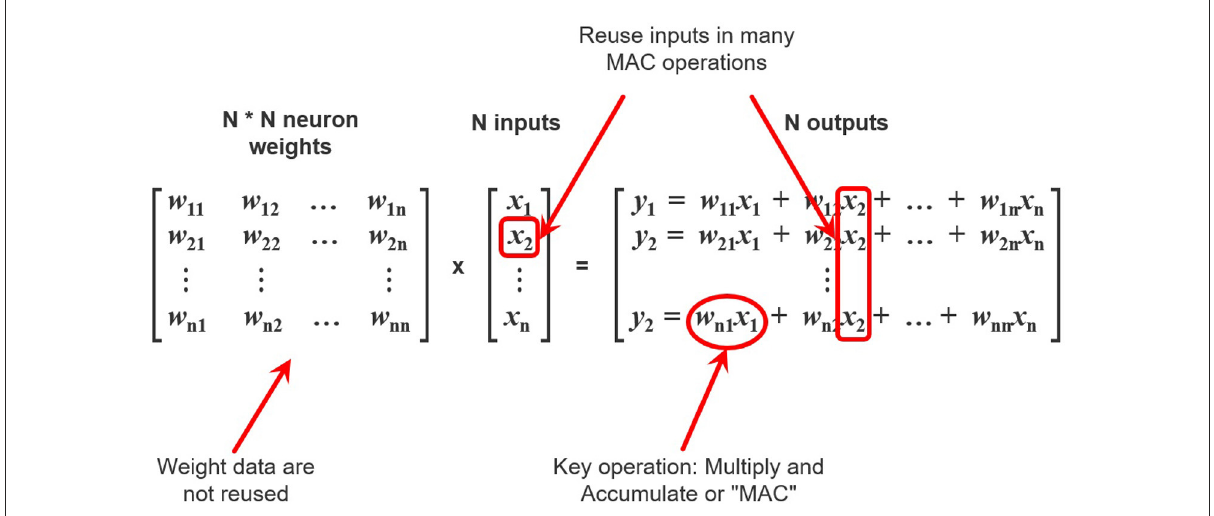
FIGURE2 A schematic view of neural network computations. Elements of input vector x are reused n times while weights w ij are used